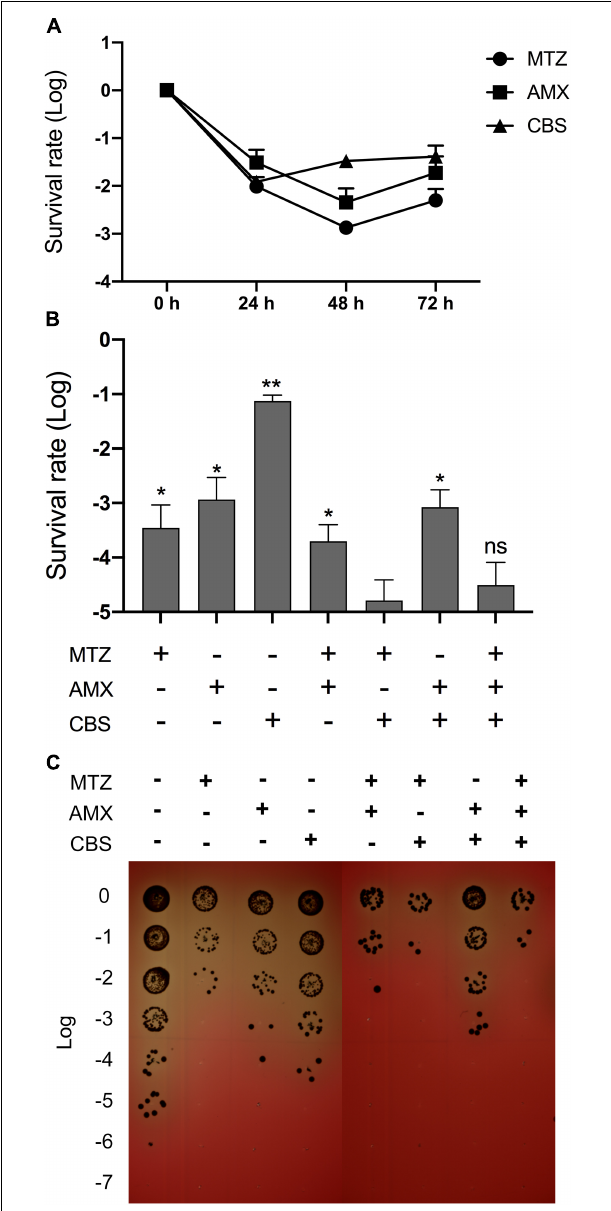
FIGURE 3 | CBS plus MTZ dramatically suppressed P. gingivalis persisters in biofilm mode. P. gingivalis cells in biofilm mode were treated with MTZ (100 mg/L), AMX (100 mg/L), and CBS (100 µ M) or different combinations of these medications for 24, 48, and 72 h, respectively. (A) The survival rate of P. gingivalis persisters after single drug treatment. (B) The survival rate of P. gingivalis persisters after 72-h treatment, with reference to the most effective group (MTZ + CBS). * P < 0.05; ** P < 0.01; ns: no significance. Data in (A,B) represent the mean ± SD of three independent experiments. (C) Plate culture of P. gingivalis persisters after 72-h treatment, randomly chosen from three independent experiments.